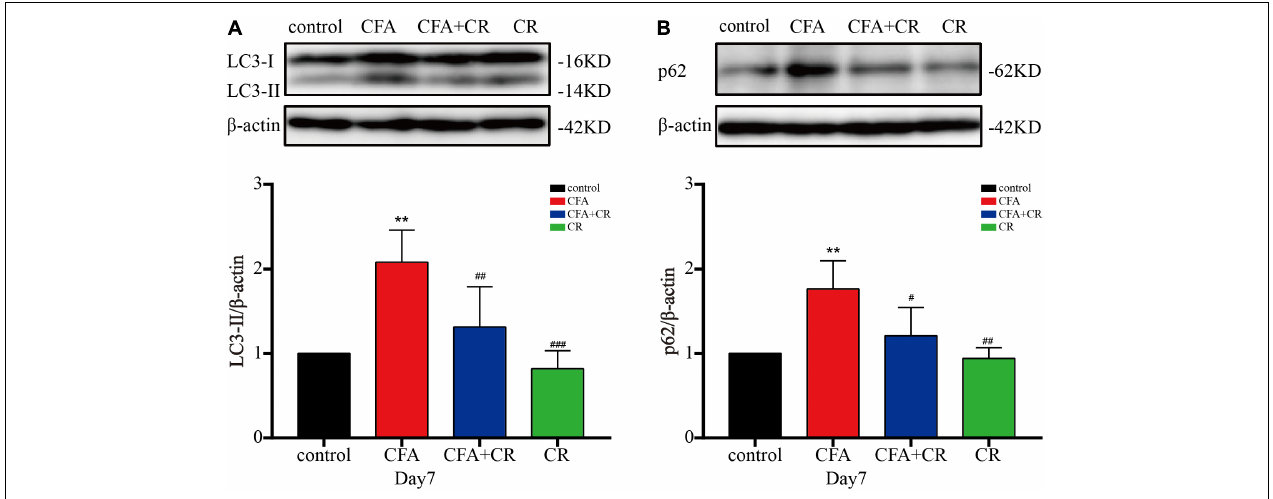
FIGURE 3 | CR ameliorates autophagic flux in the spinal cord after CFA injection. Protein expressions of LC3-II (A) and p62 (B) of mice in the control, CFA, CFA + CR and CR groups, respectively. Values are expressed as mean ± SD and were analyzed by one-way analysis of variance, followed by a Turkey’s post-hoc test, n = 4 per group. ∗∗ P < 0.01, compared to control group; ### P < 0.001, ## P < 0.01, # P < 0.05, compared to the CFA